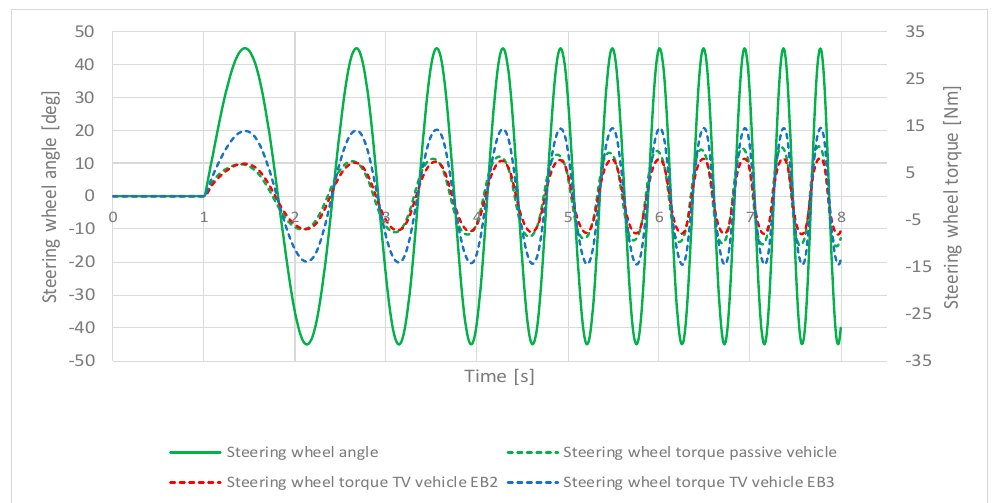
Figure 20. The EB2 (red) and EB3 (blue) sine steer compared with passive vehicle (green).